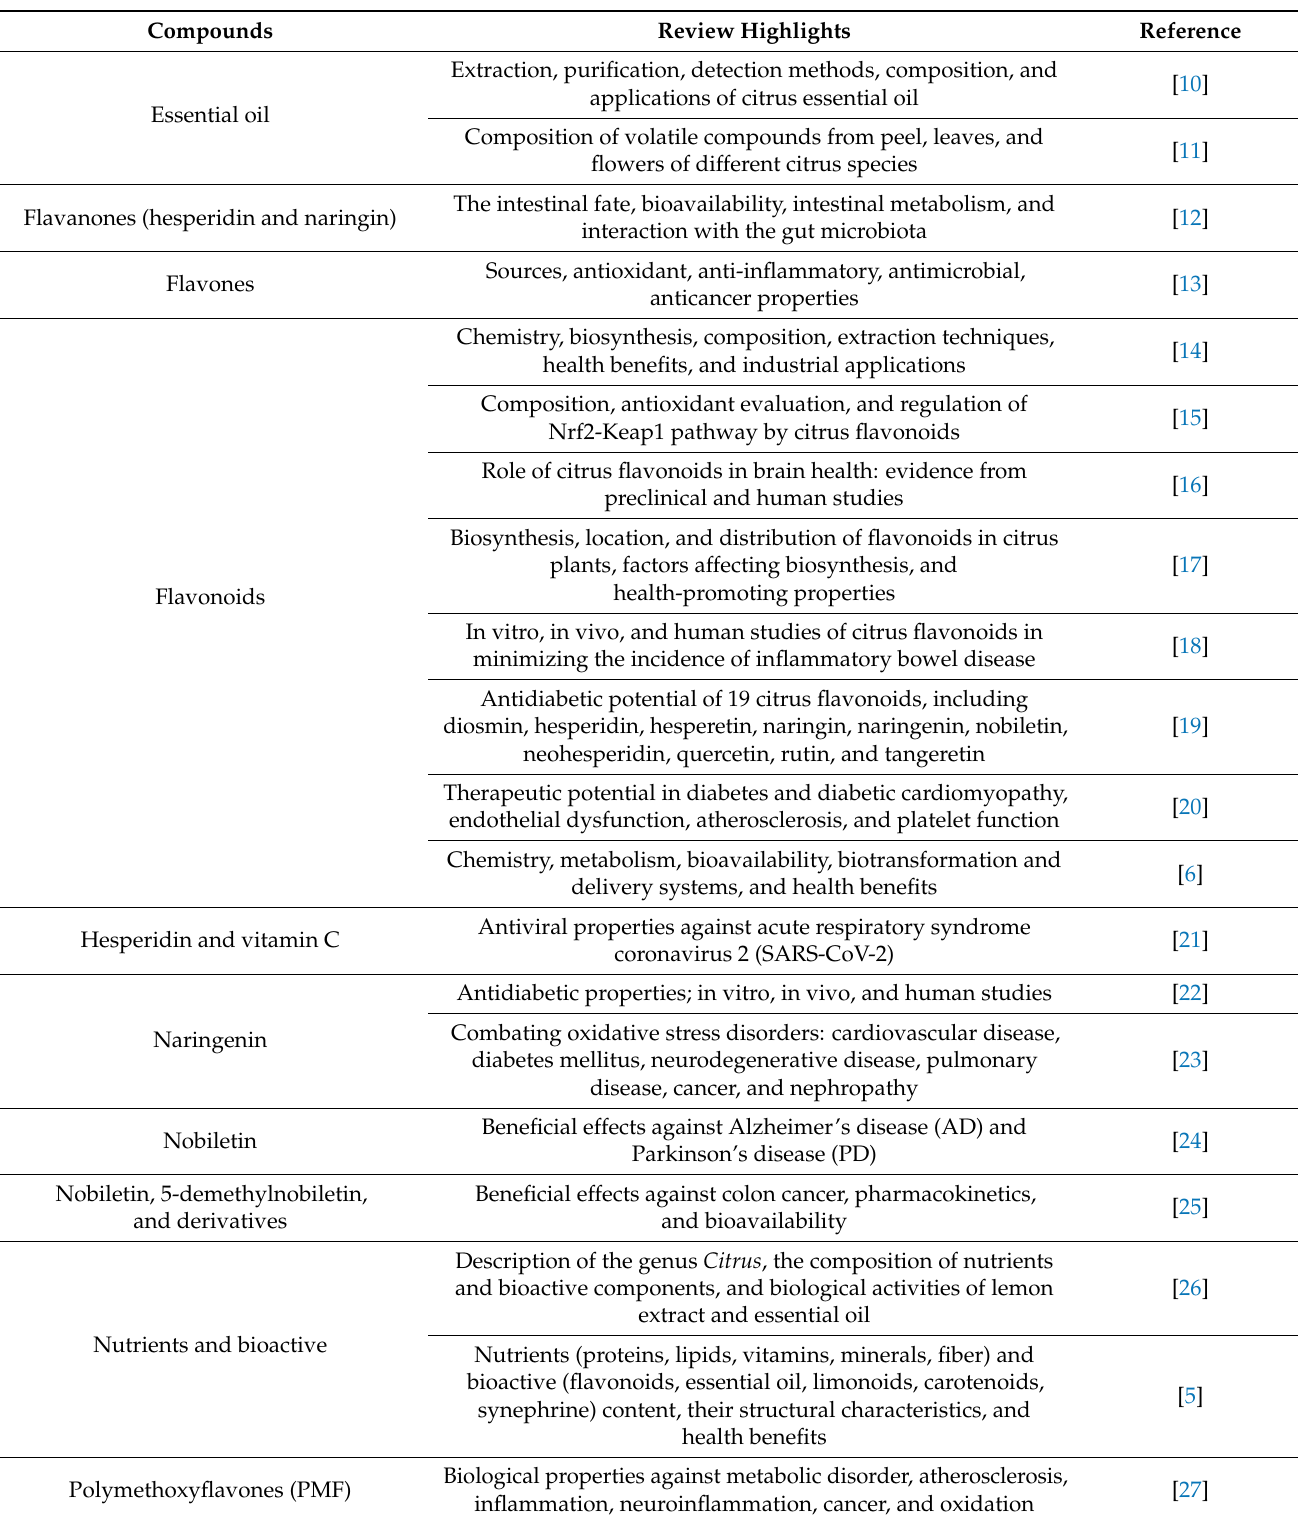
Table 2. List of recently published outstanding reviews on composition and health benefits of citrus bioactive